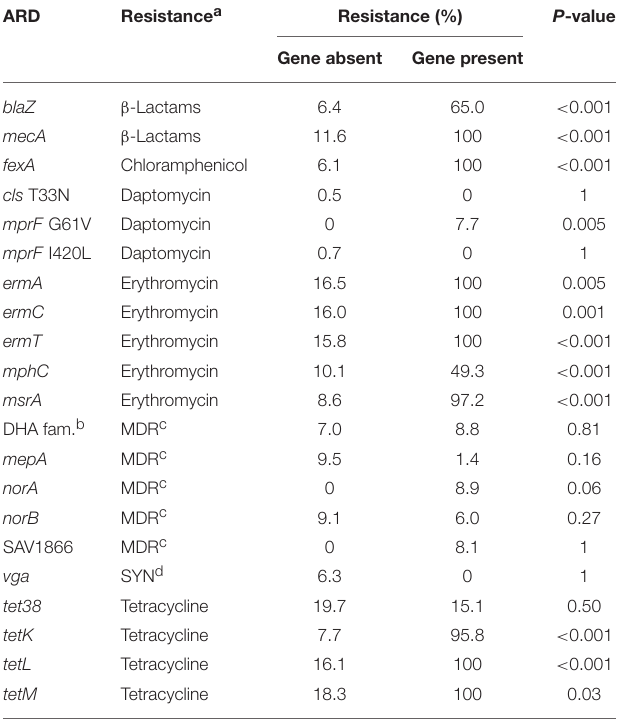
TABLE 3 | Relative frequency of drug-specific resistance in bovine non- aureus staphylococci isolates conditional on the presence or absence (% Resist | Gene status) of a particular antimicrobial resistance determinant